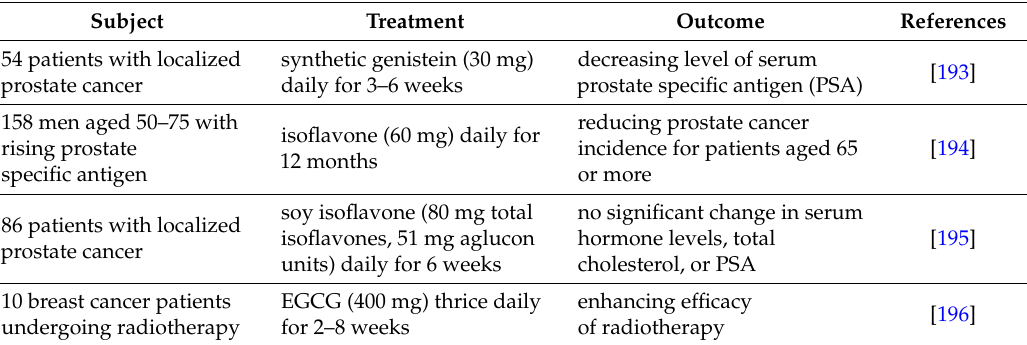
Table 6. Summary of clinical trials with polyphenols in various